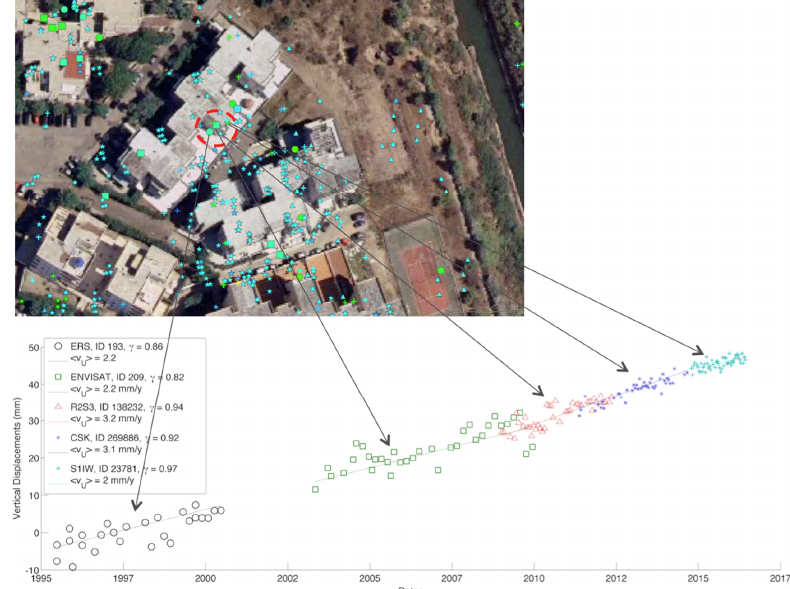
Figure 6. Temporal trend of the vertical displacement corresponding to the area on the ground delimited by the red dotted circle. Displacement values from different sensors are connected together through a minimum-norm paradigm.